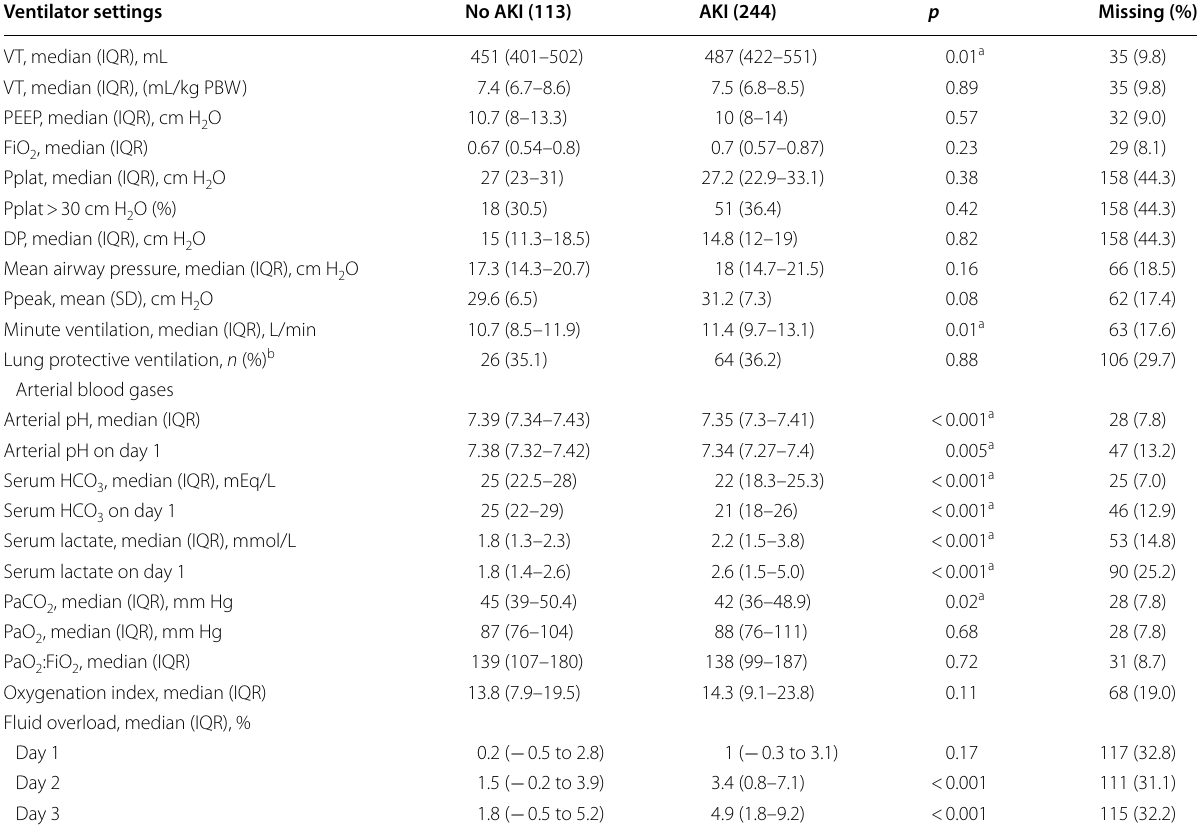
Table 2 Ventilator settings averaged on day 1–3, arterial blood gas, and fluid overload in patients with and without acute kidney